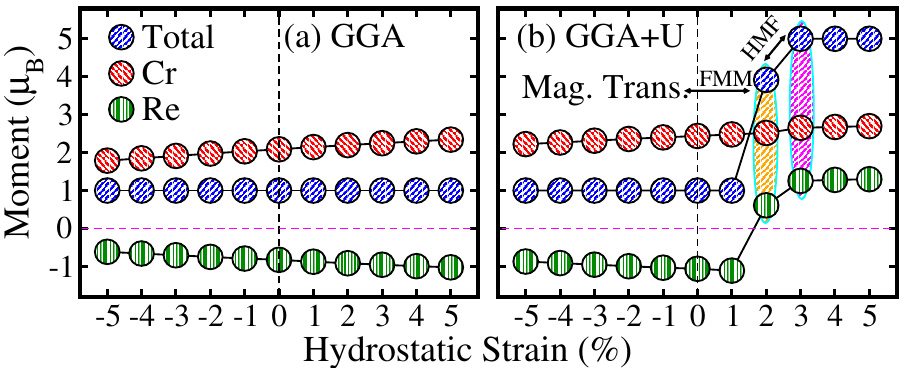
Figure 8. Calculated total and partial magnetic moments of Sr 2 CrReO 6 within ( a ) GGA and ( b ) GGA+ U schemes as a function of hydrostatic strains along the [111]-direction. First shaded region (orange color in b ) represents the magnetic transition from half-metallic ferri- (HM FiM) to ferromagnetic metallic (FMM) state, while second (magenta color) indicates the FMM to HM ferromagnetic (HMF) transition.